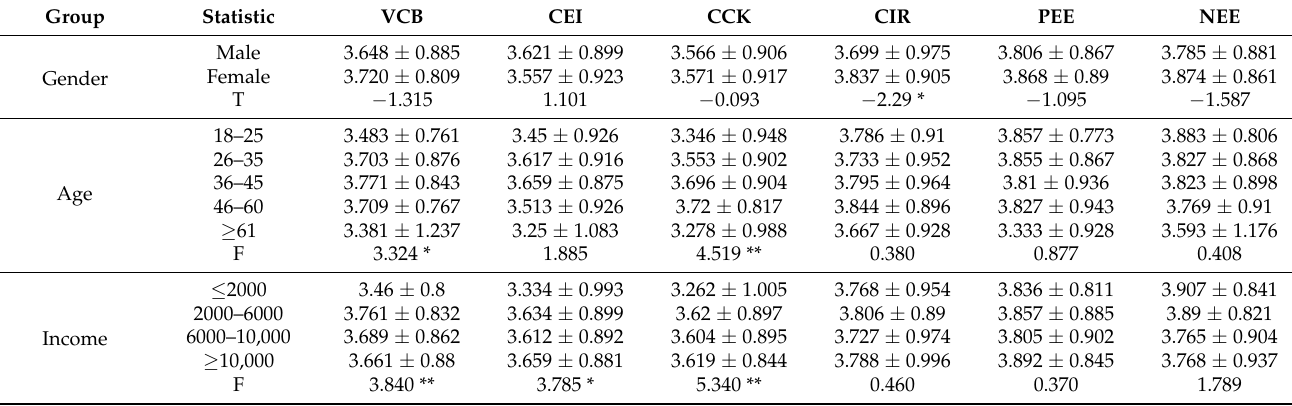
Table 6. Difference analysis of the scale scores of the present